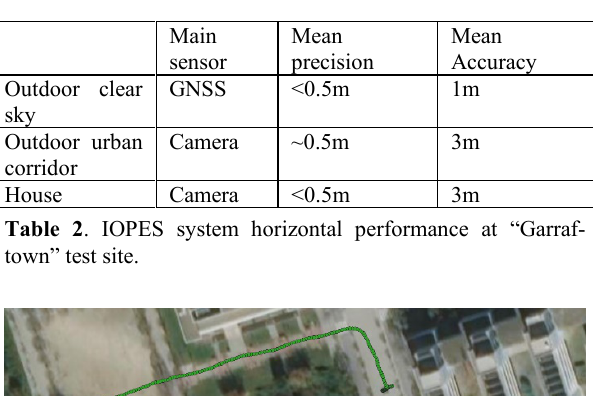
Figure 8 . Estimated “Garraf -Town” trajectory. Green dots indicate positions provided by the GNSS while red dots are the ones provided by camera-based tracking system.